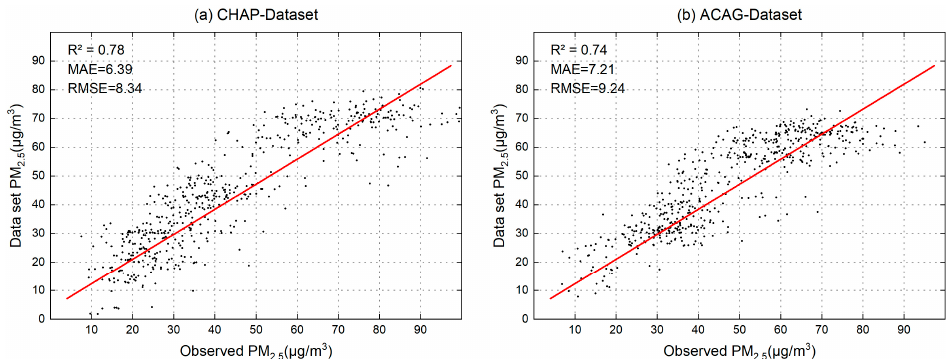
Figure 4. Comparison of the results with the dataset. ( a ) shows the fitting result between the CHAP dataset and the observation station, ( b ) shows the fitting result between the ACAG dataset and the observation station.